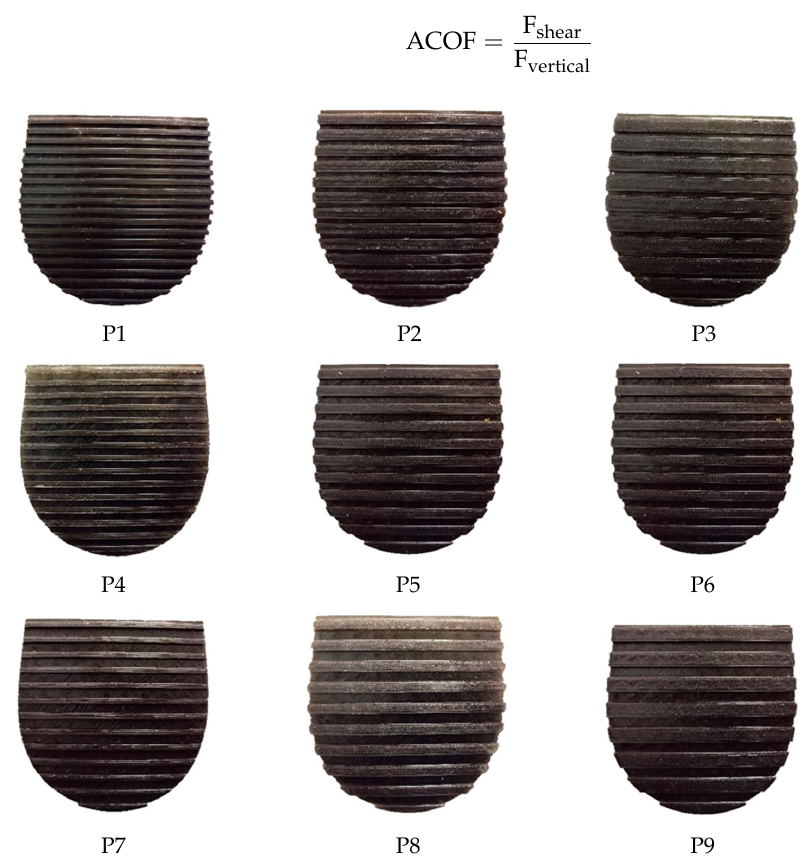
Figure 2. The developed parametrically modified footwear outsole designs.